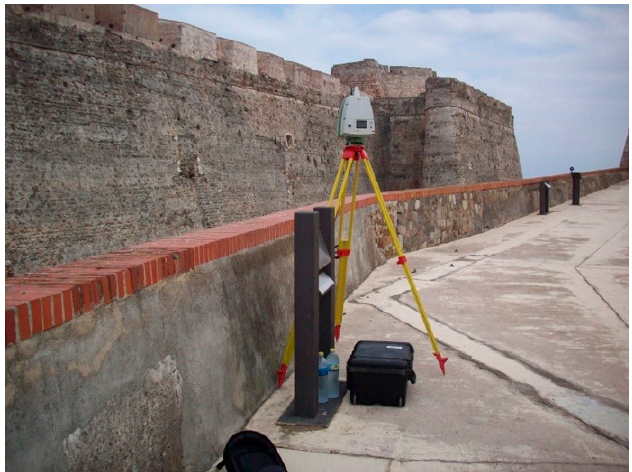
Figure 1. Leica ScanStation C5 terrestrial laser scanner (TLS).